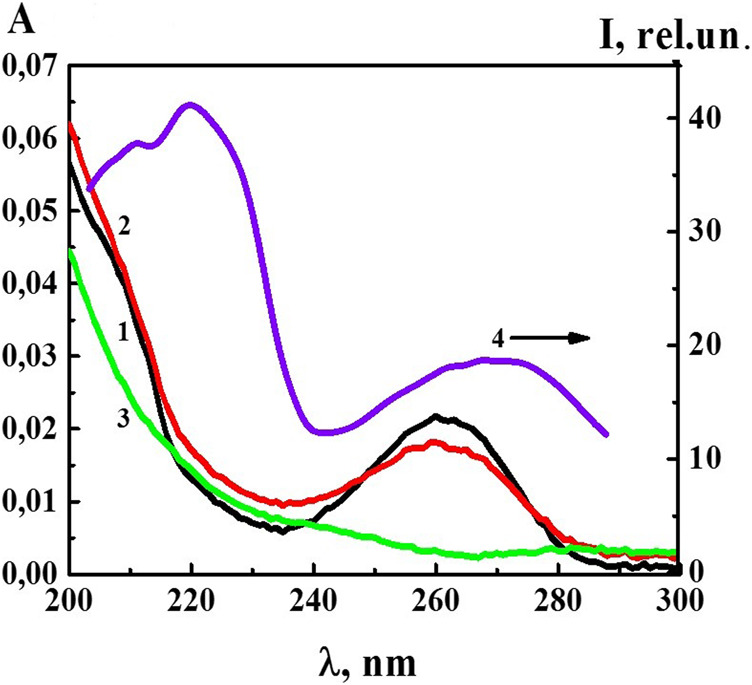
The absorption spectra of the 4-AP systems: 1) 1·10−6 М, 2) 1·10−12 М, 3) S-24, and the excitation spectra (λ
em340 nm) of the 4-AP system at 4) 1·10−6 М. Measurements were performed at 25 ± 0.1°C.